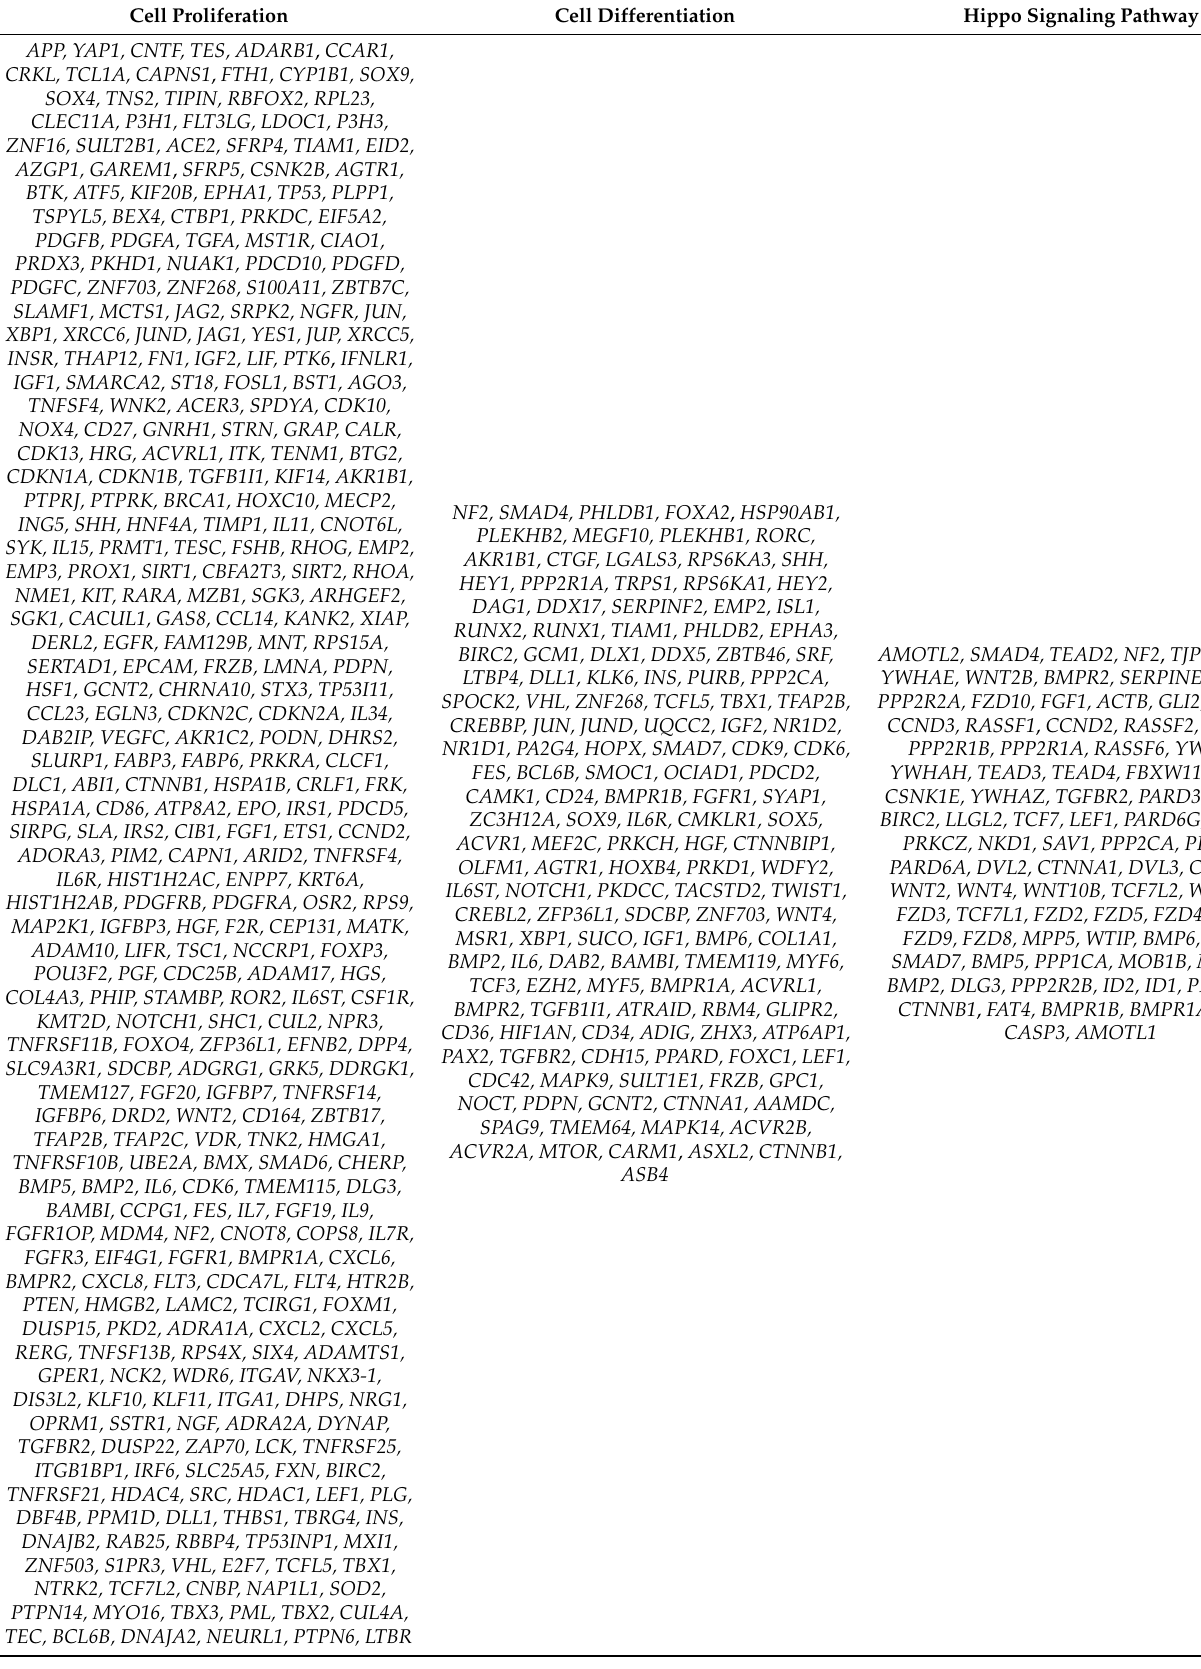
Table 2. The integrated gene sets obtained from enrichment analyses of